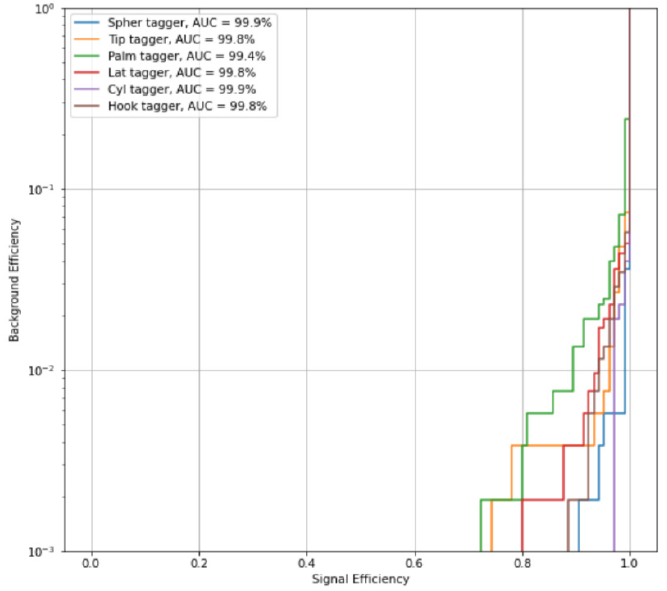
Figure 8. Receiver operating characteristic (ROC) curve for test data (six categories).